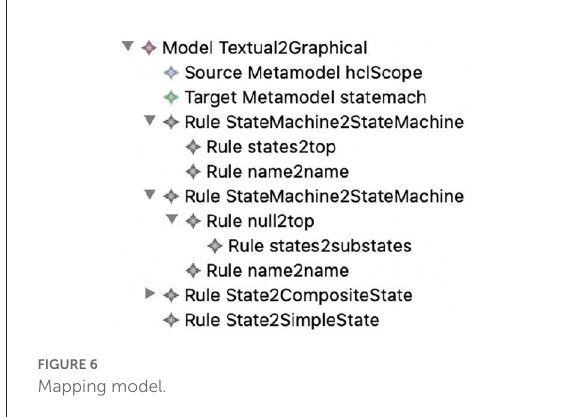
FIGURE6 Mapping model.